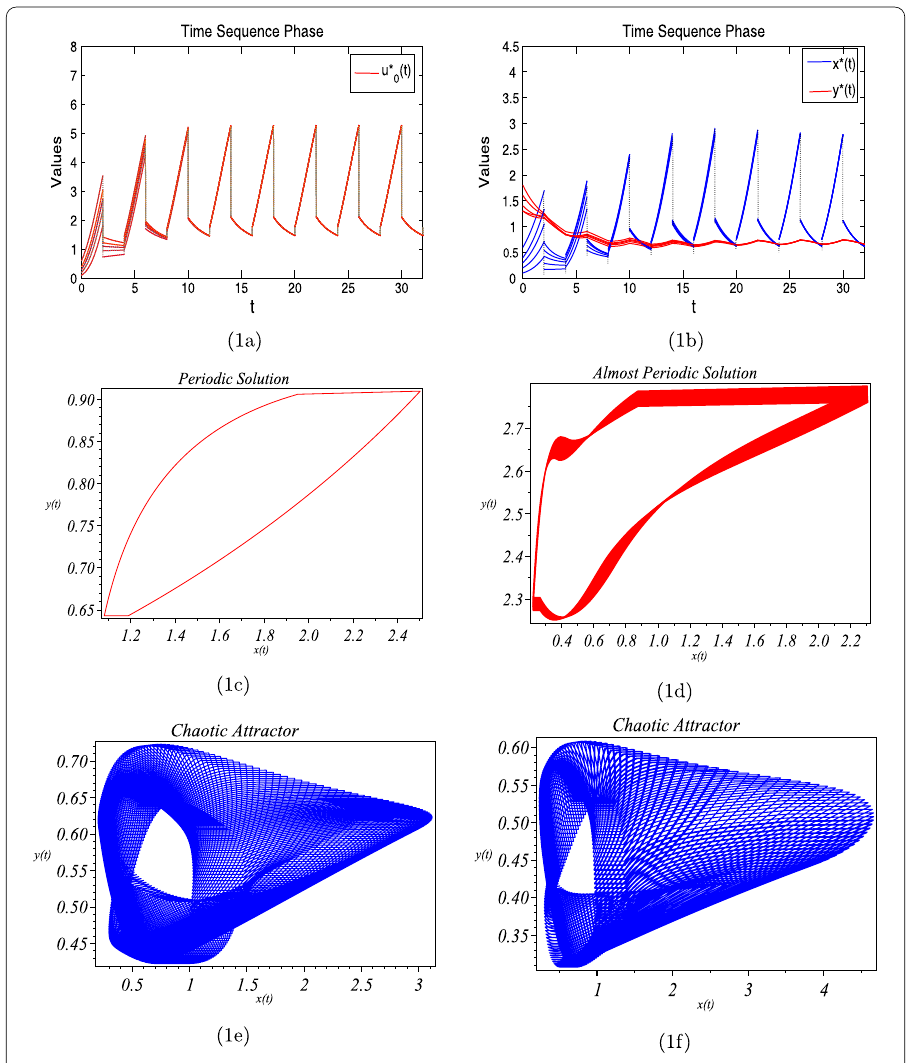
Figure 1 Dynamics behavior of model (5) and (4); for model (5), we take initial values x 0 = 0.1,0.2,0.3,0.4,0.6, respectively; for model (4), we take initial values ( x 0 , y 0 ) = (0.1,1.8), (0.2,1.6), (0.3,1.4), (0.4,1.5),